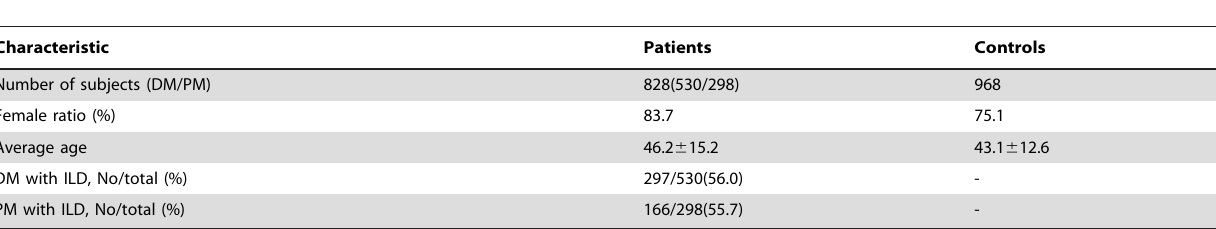
Table 1. Clinical data for PM/DM patients and